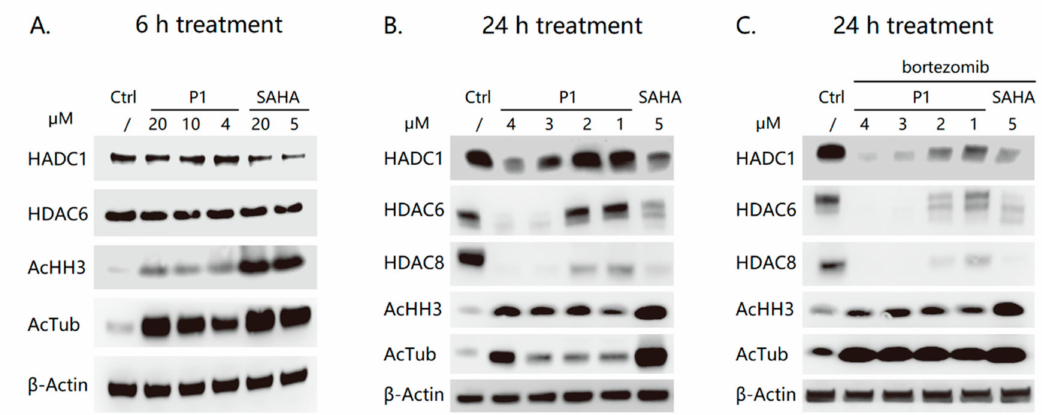
Figure 4. Western blot analysis of levels of proteins of interest in RPMI-8226 cells. ( A ) The cells were treated with P1 and SAHA at the indicated concentrations for 6 h. ( B ) The cells were treated with P1 and SAHA at the indicated concentrations for 24 h. ( C ) The cells were pre-incubated with 10 nM bortezomib before the treatment of P1 and SAHA at the indicated concentrations for 24